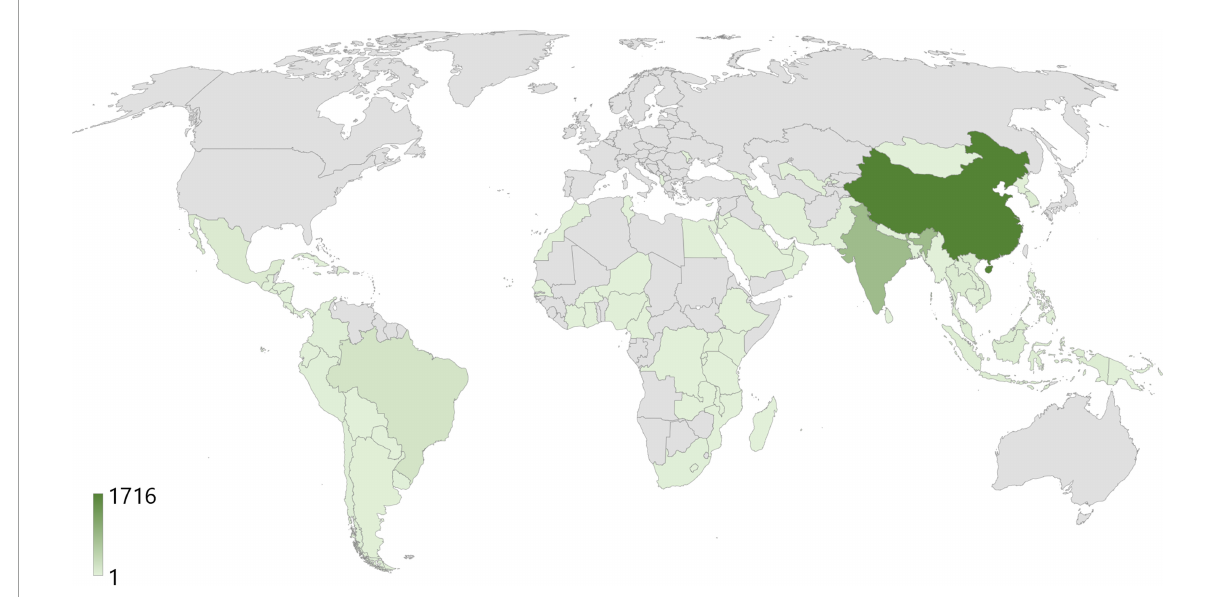
FIGURE1 Clean development mechanism implementations by country ( N = 3655).